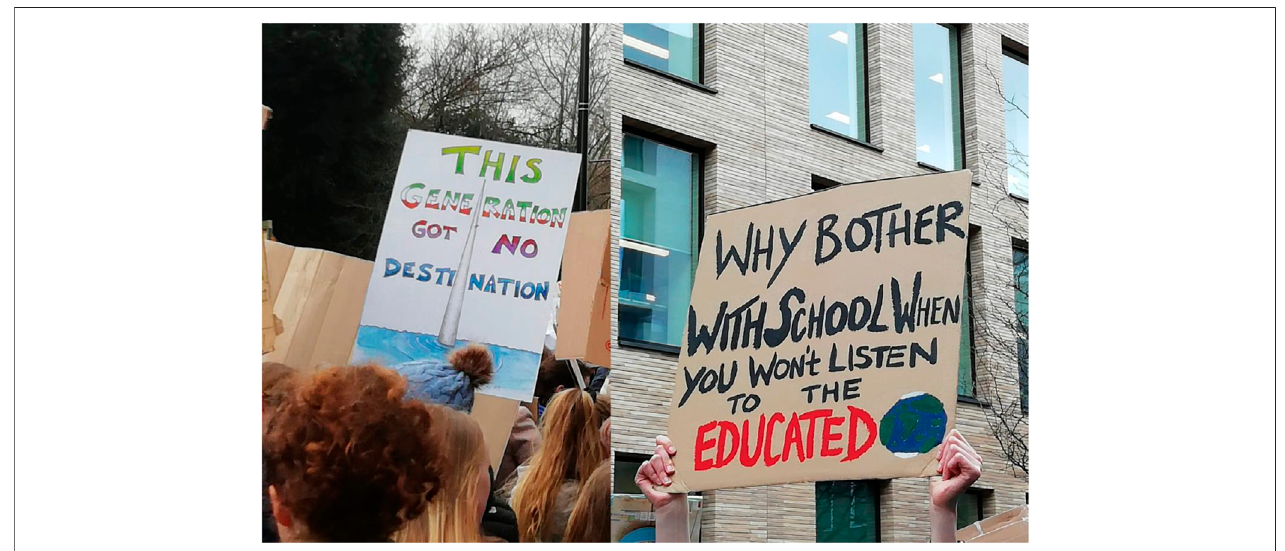
FIGURE2| InTheirOwnWords:Signsbystudentsexpressingfrustrationatthe fi rstmajorSchoolStrikeForClimatemarchinIreland,onFridaytheMarch15,2019 (Photographer is EN).